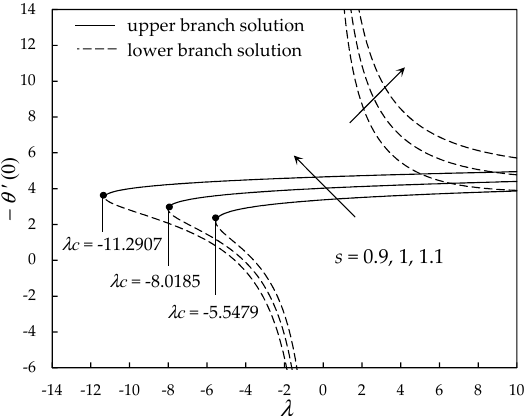
Figure 9. Variation of the reduced local Nusselt number −𝜃′(0) with the mixed convection parameter λ for various values of the suction parameter s when φ = 0.01, Nr = 0.1, K = 0.1 and c = − 1 for Cu-water nanofluid.